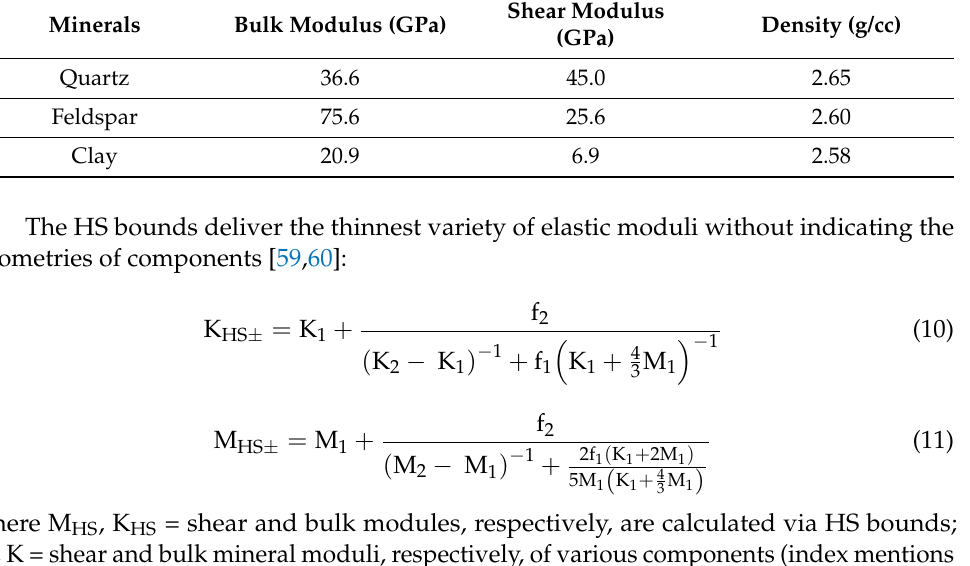
Shear Modulus Density (g/cc) (GPa)